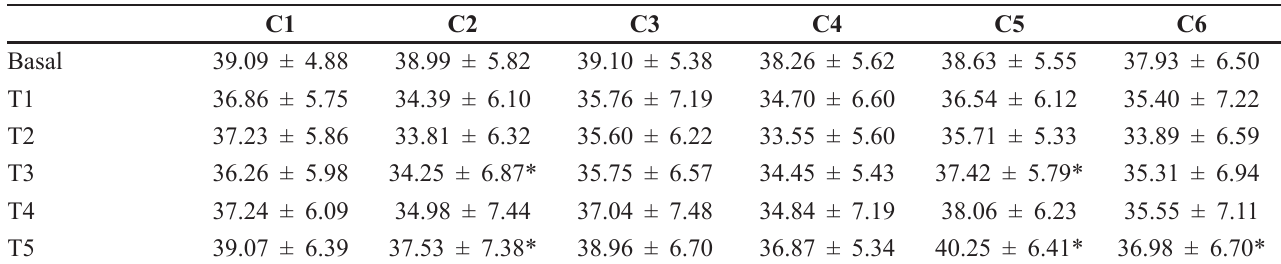
TABLE IV - Skin hydration values measured before and 1, 2, 3, 4 and 5 hours after topical application of